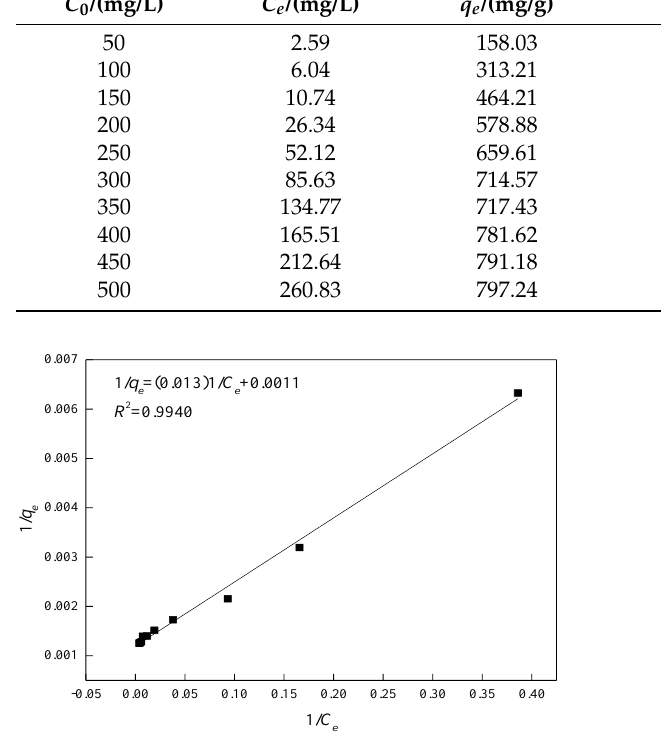
Figure 17. The regression curve of the Langmuir isotherm adsorption equation.